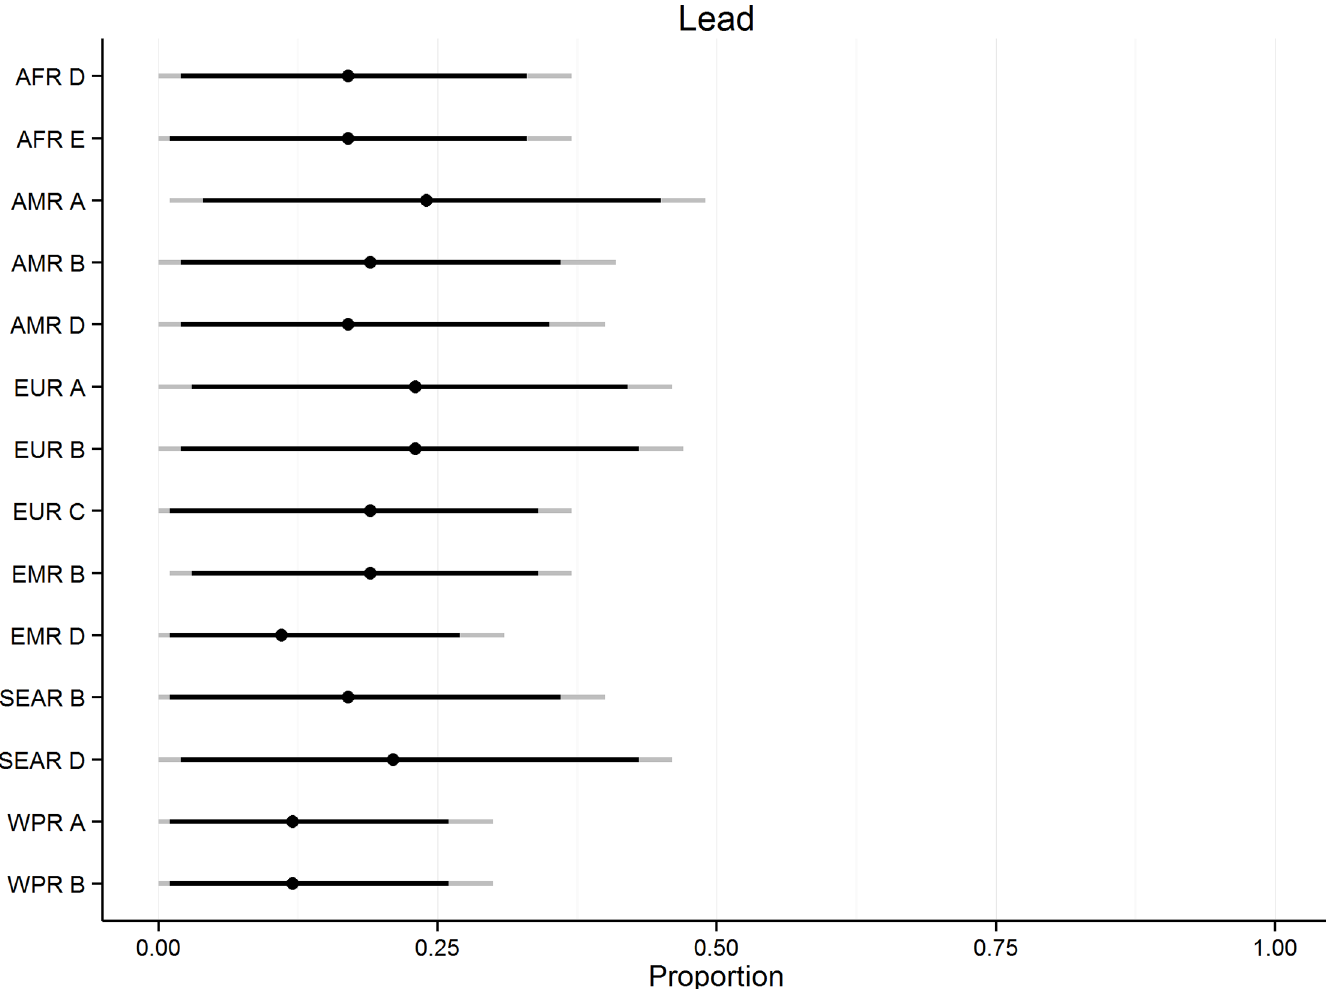
Fig 7. Subregional estimates of the proportion of disease caused by foodborne exposure to lead. Indicated on the line plot are the 2.5 th , 5 th , 50 th , 95 th and 97,5 th